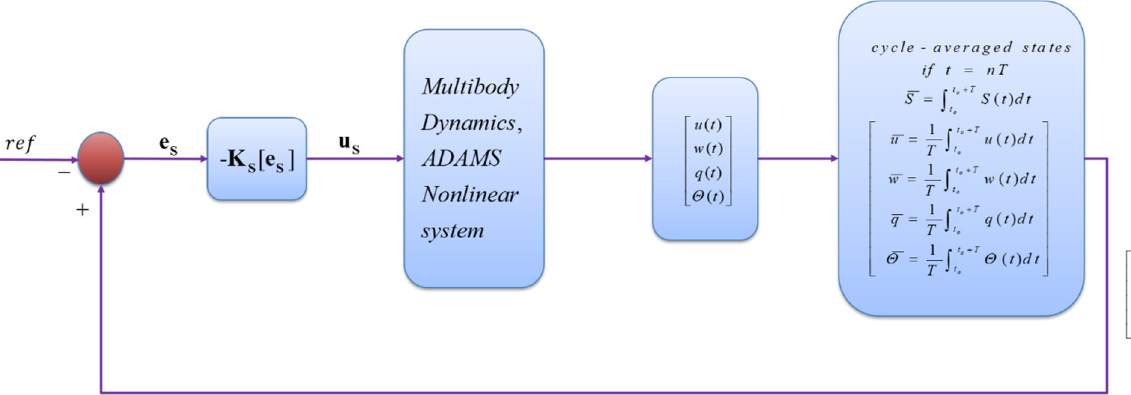
Figure 9. Schematic diagram of gain-scheduled LQR controller design for maintaining fixed flight conditions (stabilizing hovering and forward flight states).